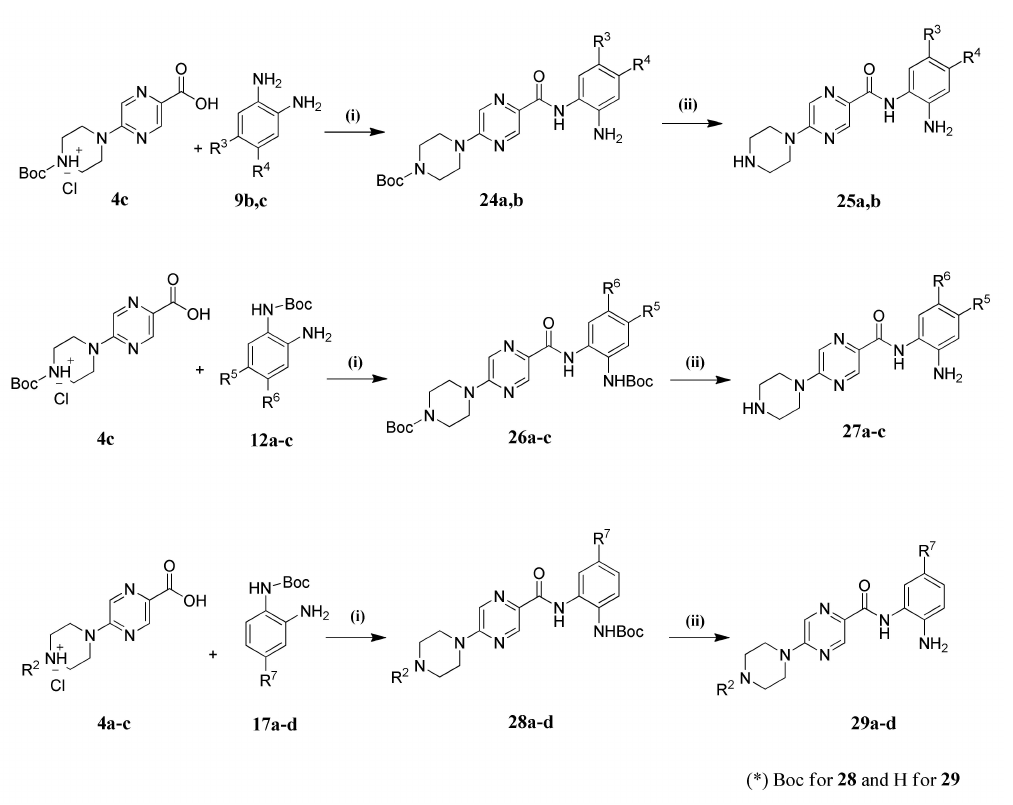
Scheme 4. Synthesis of the final compounds 21a – c and 23a – c . Reagents and conditions: ( i ) HATU, DIPEA, Dry DMF, RT, Overnight. ( ii ) TFA, DCM, 0 ◦ C, 30 min. ( iii ) 22b , 4M HCl, Dioxane, 0 ◦ C, 30